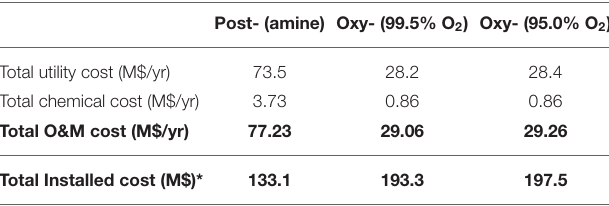
TABLE 2 | Total installed Operation and Maintenance (O&M) costs (Mello et al.,